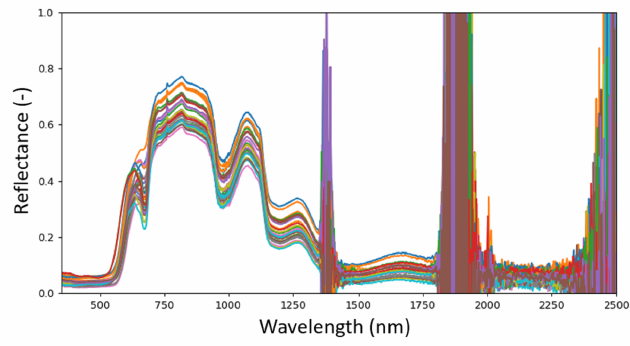
Figure 4. Raw hyperspectral reflectance spectra of some strawberry fruit samples.